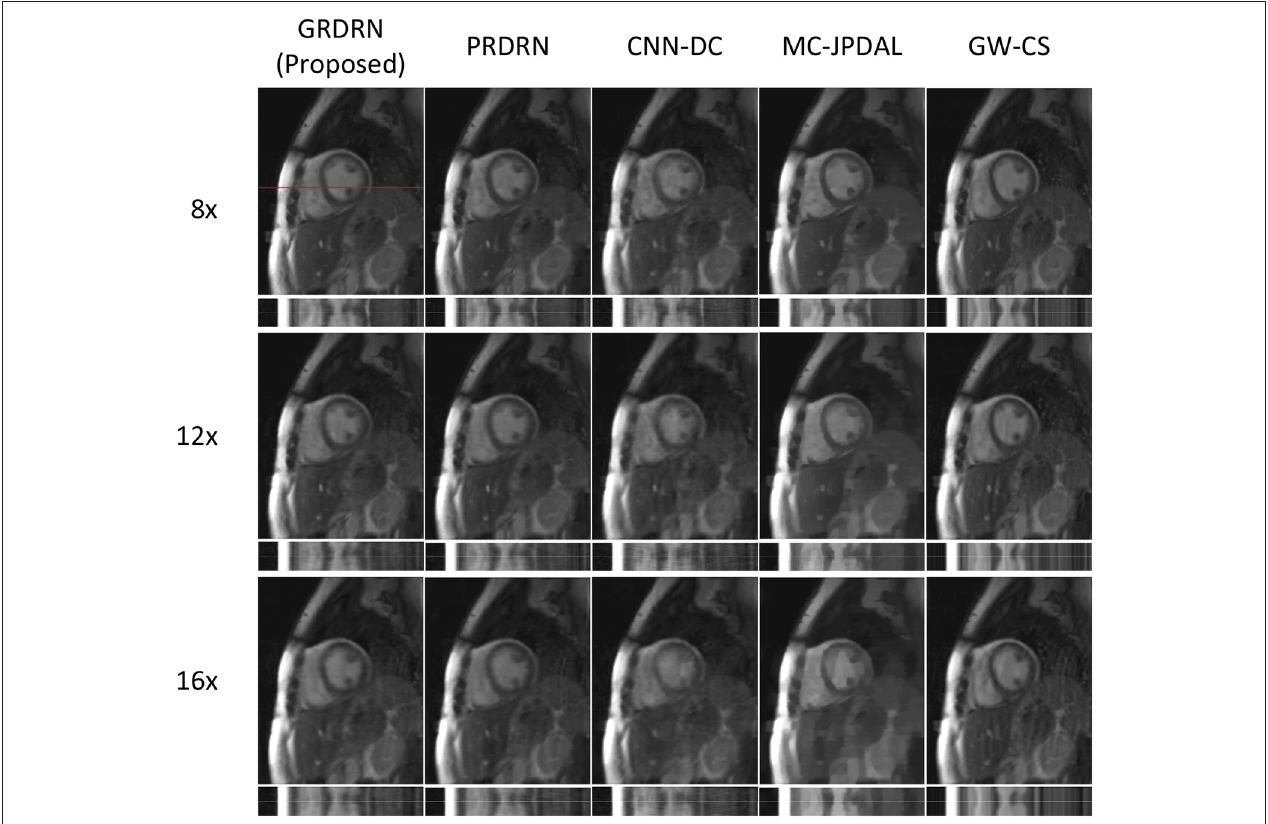
FIGURE 4 | Visual comparison of reconstructions with different reconstruction approaches for 8 × , 12 × , and 16 × acceleration rates. The temporal profile at the location indicated by the red line is shown for each